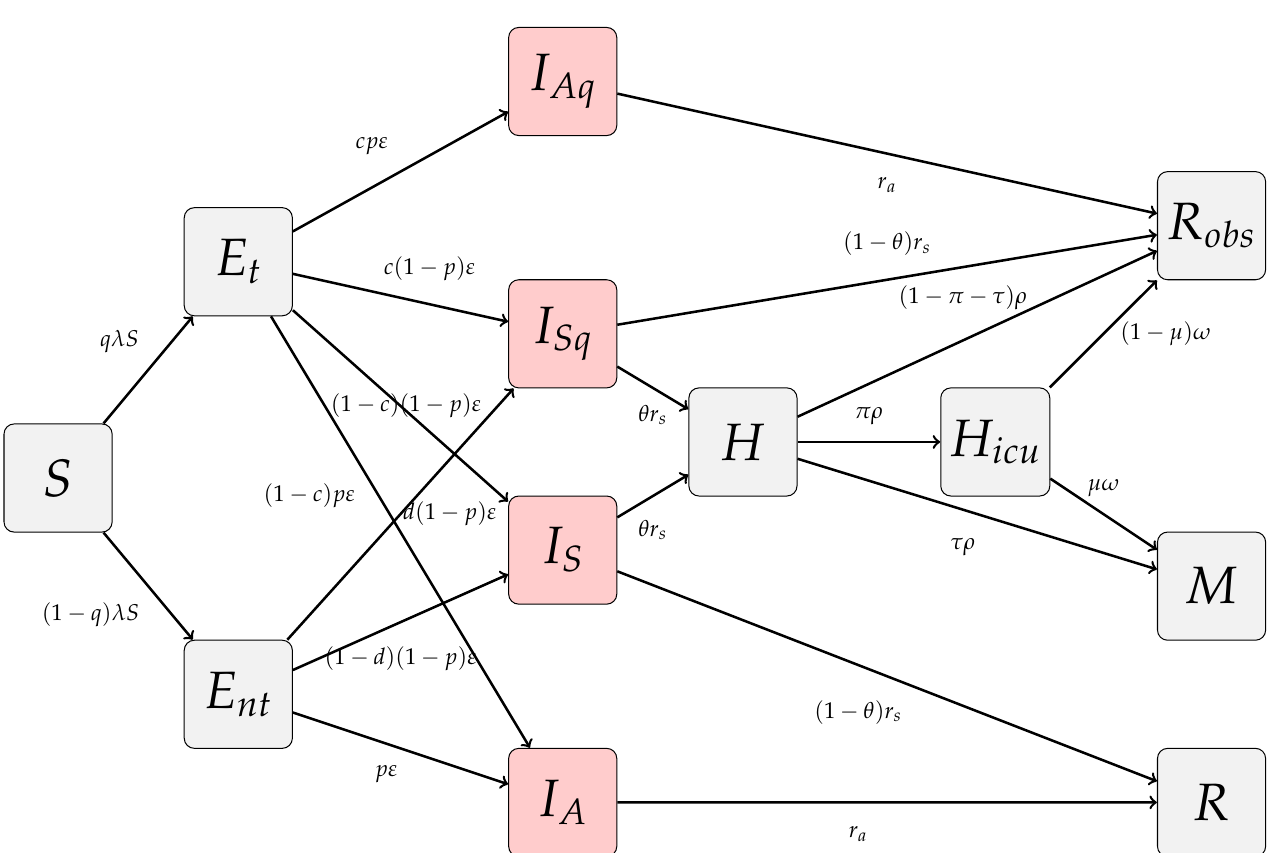
Figure 1. Schematic diagram of the homogeneous COVID-19 transmission model. Disease transmission is λ S = β ( α S C S I S + α A C A I A + α Sq C Sq I Sq + α Aq C Aq I Aq ) S , where α i and C i , for i = S , A , Sq , Aq , are the relative transmissibility and contacts N of infectious